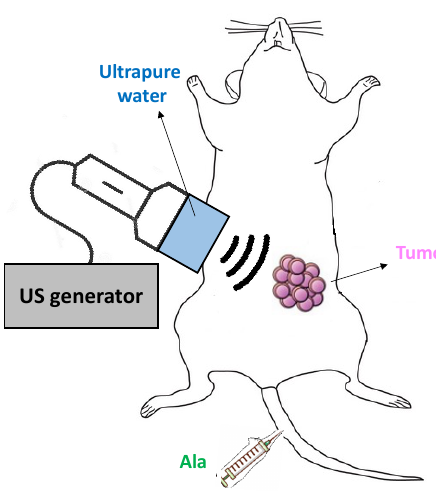
Figure 7. Representative scheme of SDT on rats. SDT-treated groups were subjected to Ala iv injection into the tail vein (375 mg/kg bw) and then exposed to US (1.5 W cm 2 , 1.8 MHz, 300 s), 4 h after the Ala iv injection.